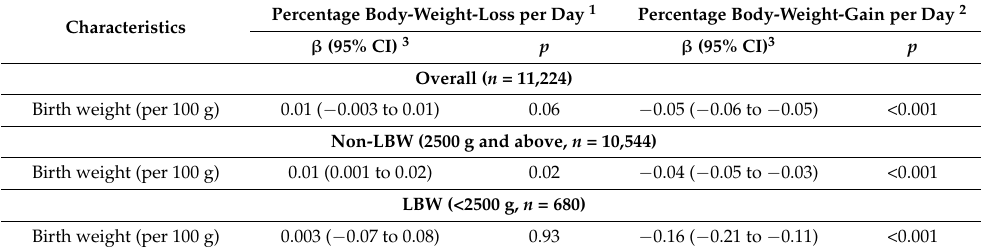
Table 3. Regression coefficients and 95% confidence intervals estimated with a continuous variable of birth weight in regression analyses, stratified by non-low birth weight and low birth weight neonates.